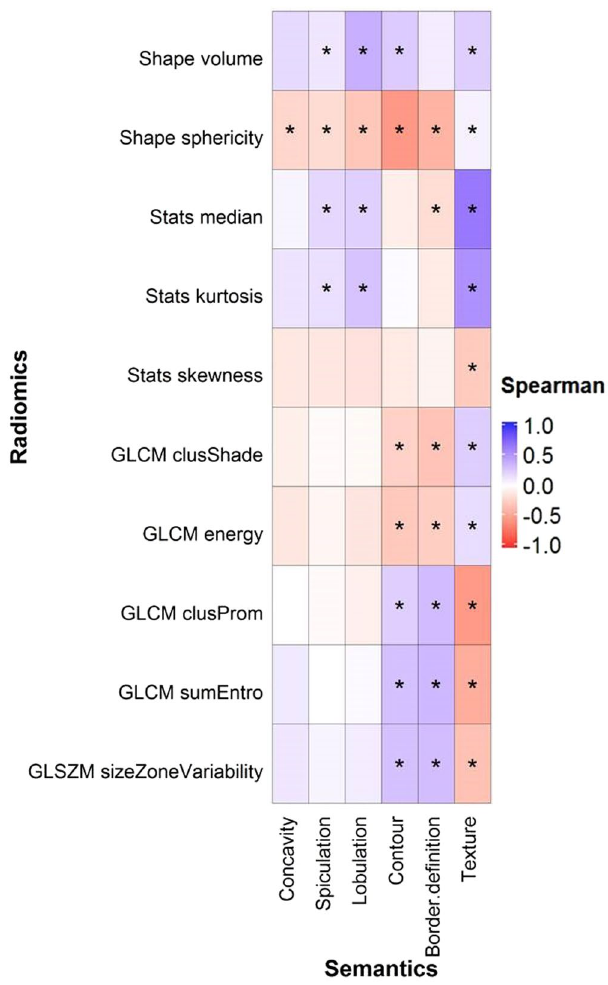
Figure 4. Association between the six categorical semantic and ten unfiltered radiomic features assessed with Spearman coefficient correlation. * Indicates that the association was significant (q-value ≤